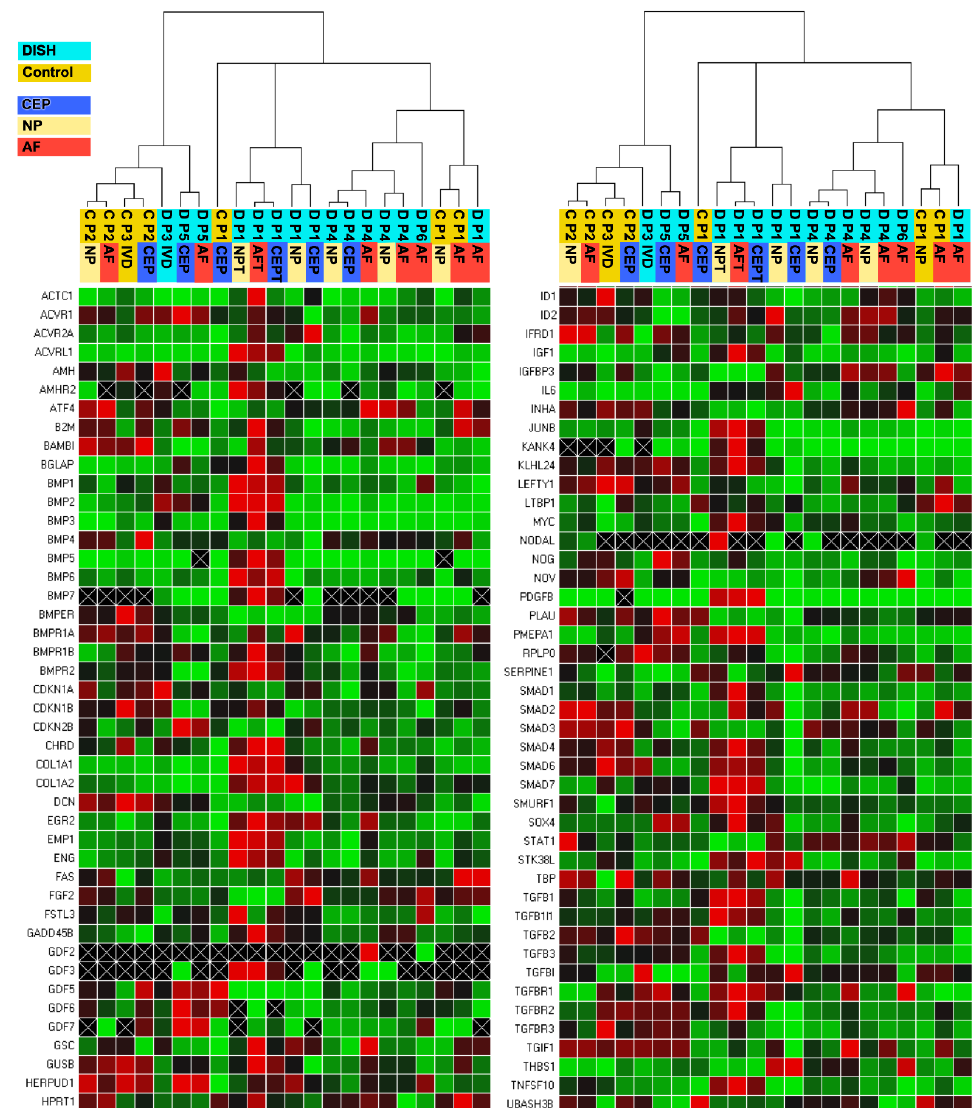
Figure 2. Clustergram displaying hierarchy based on the degree of similarity of expression for different samples and normalised gene expression heat map of relative gene expression at 88 genes of PrimePCR™ of the TGFβ -BMP Signalling Pathway Plus H96. Red indicates up-regulations, green indicates down-regulations and black indicates no regulations. The lighter the shade of colour, the greater the relative normalised expression difference. If no normalised expression value could be calculated, this is shown in black with a white X. Relative gene expression was estimated using ACTB and GAPDH as the two reference genes. Samples encoded in orange are samples categorised as trauma patients = control (C), and samples in light blue are from patients that were diagnosed with DISH (D). Tissue types were colour-coded in dark blue for CEP, in yellow for NP, and in red for AF.